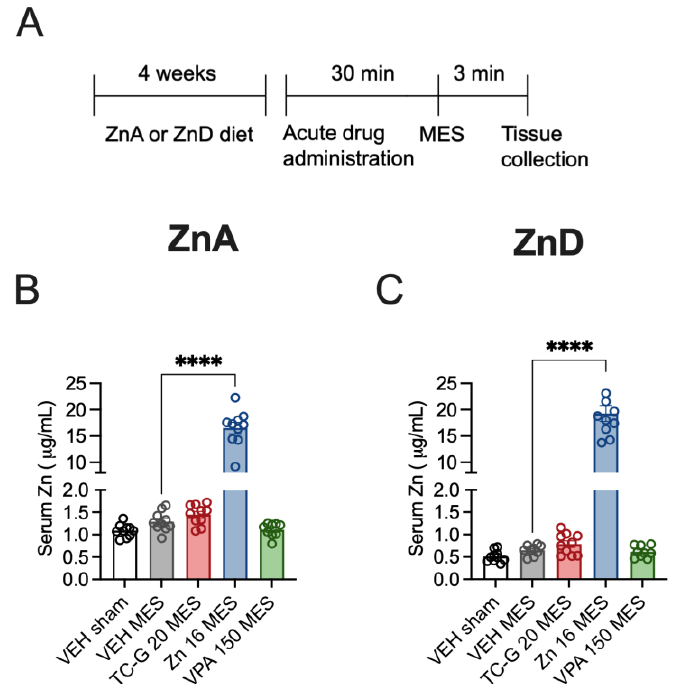
Figure 2. Acute effects of TC-G 1008 (TC-G) (20 mg/kg), ZnCl 2 (16 mg Zn/kg) or VPA (150 mg/kg) and maximal electroshock (MES) seizures on total zinc concentration in the sera of mice fed the ZnA or ZnD diet. ( A ) Experimental paradigm. Mice were fed the ZnA or ZnD diet for 4 weeks. Following a 4-week dietary zinc restriction, drugs were administered acutely i.p. Control mice received VEH i.p. 30 min later, seizures were generated by supramaximal current intensity of 50 mA. Non-stimu- lated (sham) mice received VEH but they did not receive the electrical stimulus. The serum samples were obtained ca. 3 min after MES. Total serum zinc concentration was measured by Inductively Coupled Plasma Optical Emission Spectrometry (ICP-OES). ( B , C ) Data are expressed as means ± SEM. They were analyzed by one- way ANOVA and the Dunnett’s multiple comparison test. n = 9 – 10 in each group. Statistical details: ( B ) F(4,44) = 191.4, p < 0.0001, ( C ) F(4,43) = 142.1, p < 0.0001 (B-C one-way ANOVA). **** p < 0.0001 vs. VEH MES group (Dunnett’s multiple comparison test).